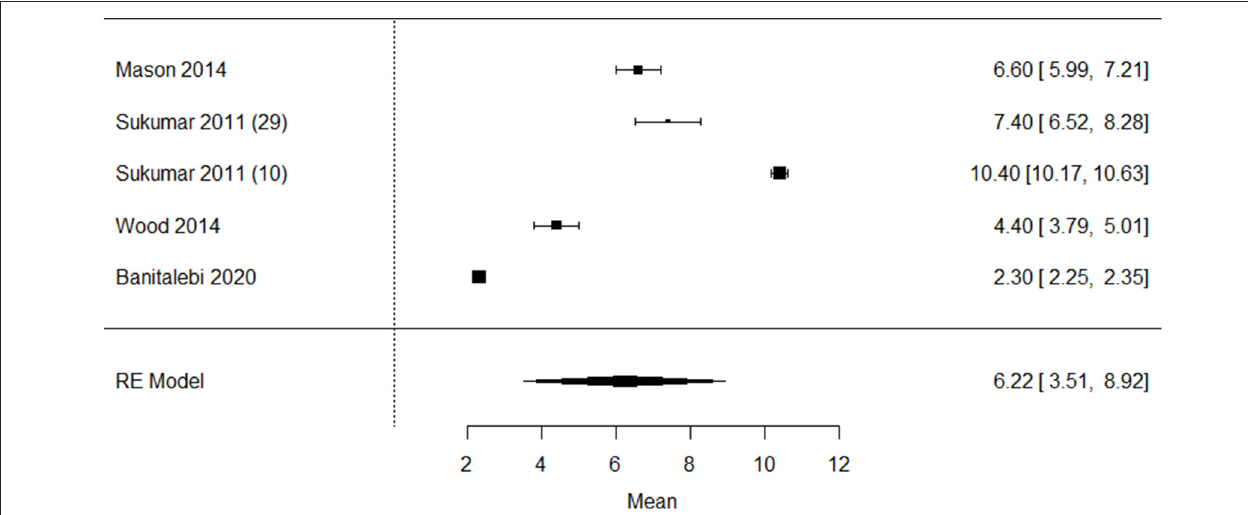
FIGURE 4 | Forest plot of included studies on vitamin D intake (ug/day) in older adults with overweight/obesity mean [95% confidence interval], RE, random effects.